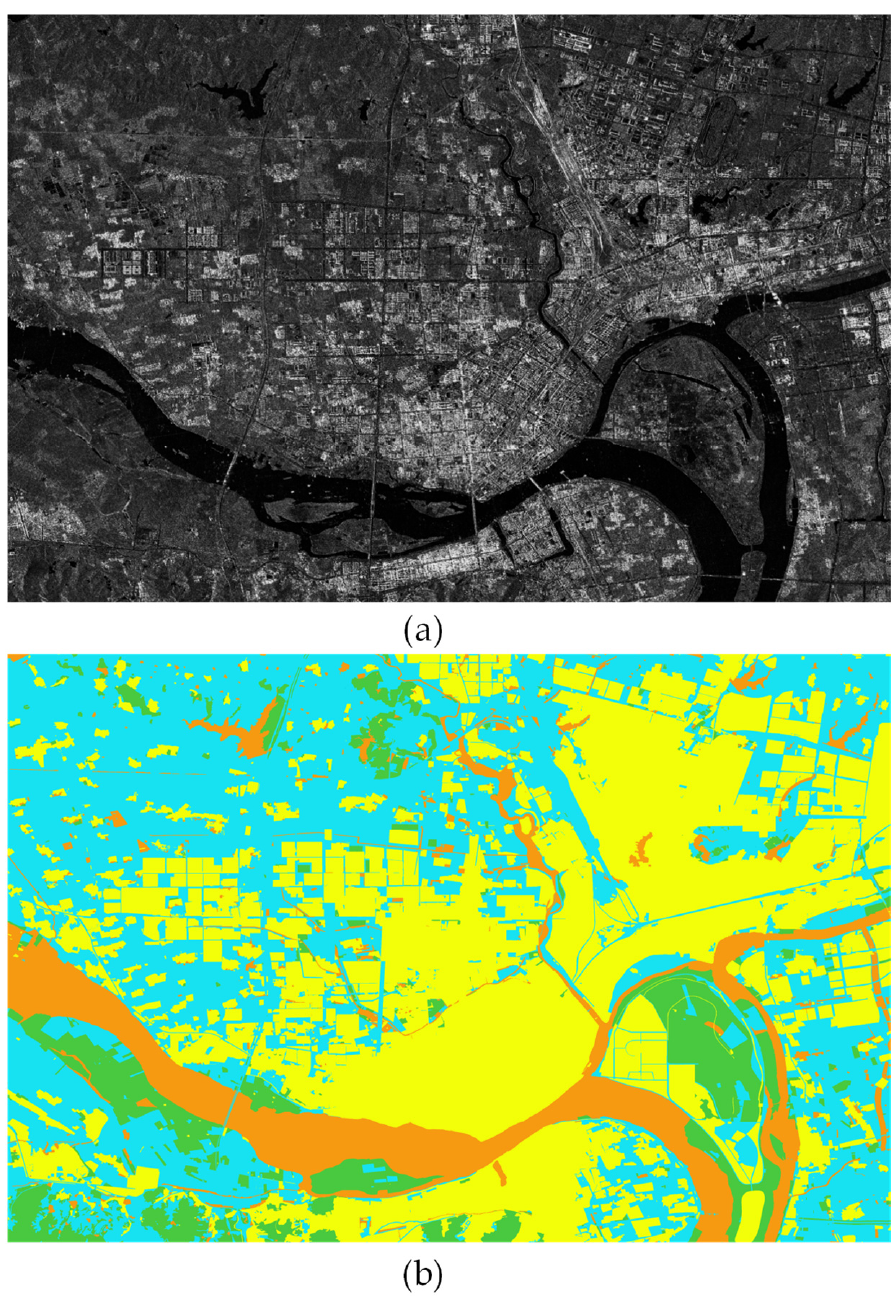
Figure 9. ( a ) Real SAR image